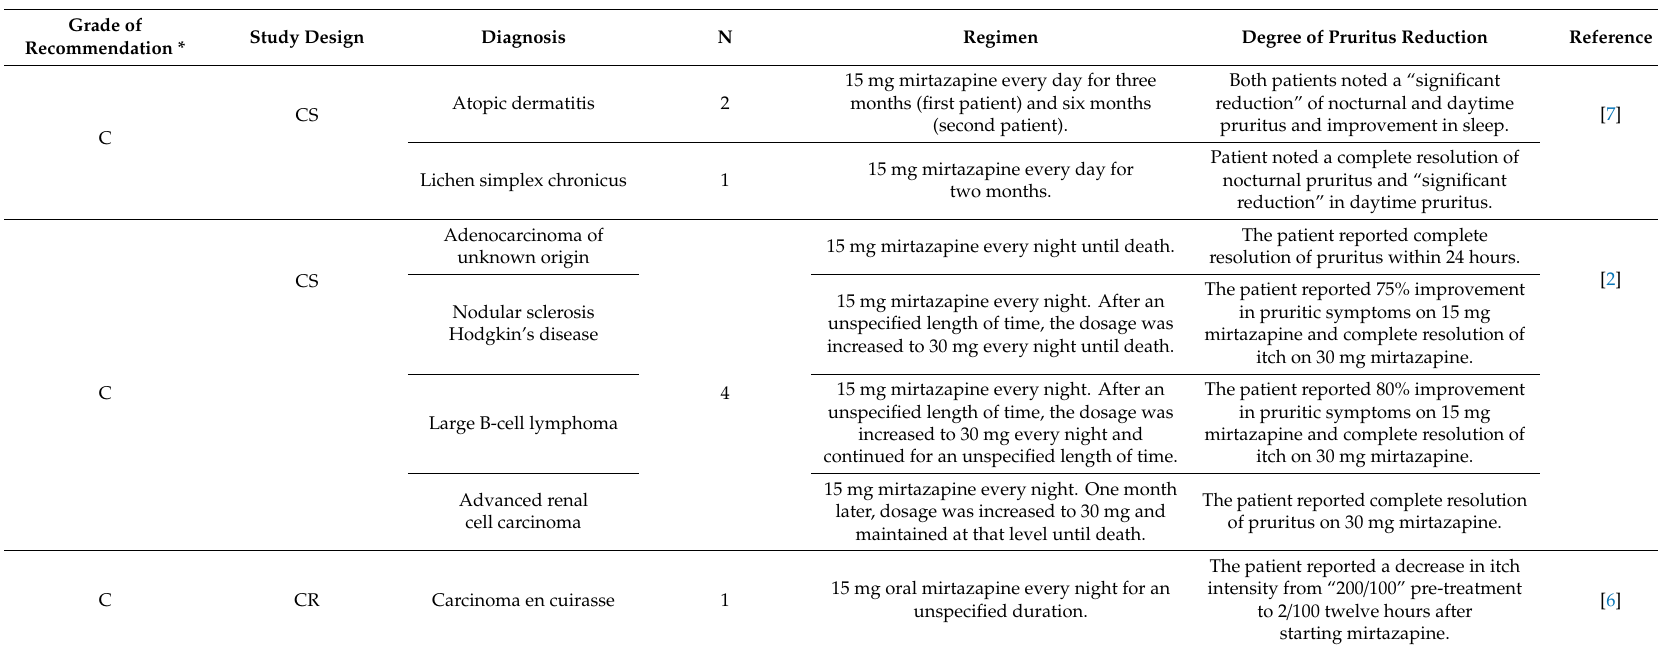
Table 1. Summary of studies examining the e ff ects of mirtazpine in treating chronic pruritus. * Determined based on the Oxford Centre for Evidence-based Medicine (CEBM) Levels of Evidence. Mirtazapine ; CS , case series; CR , case